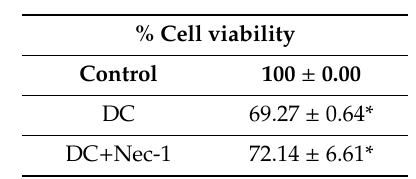
Table 1. Cell viability. Measurement of cell viability of Caco-2 cells upon 24 h treatment with DC in